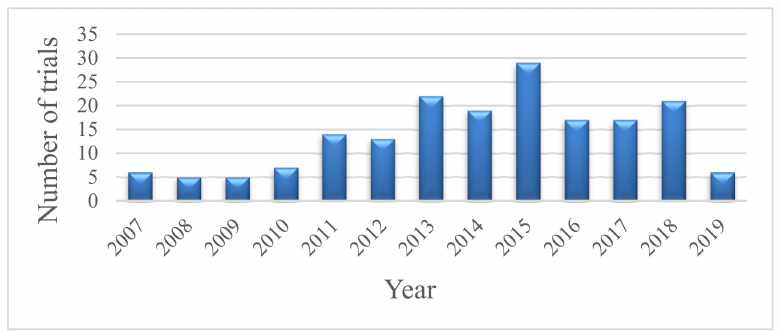
Figure 1. The number of trials on human by year